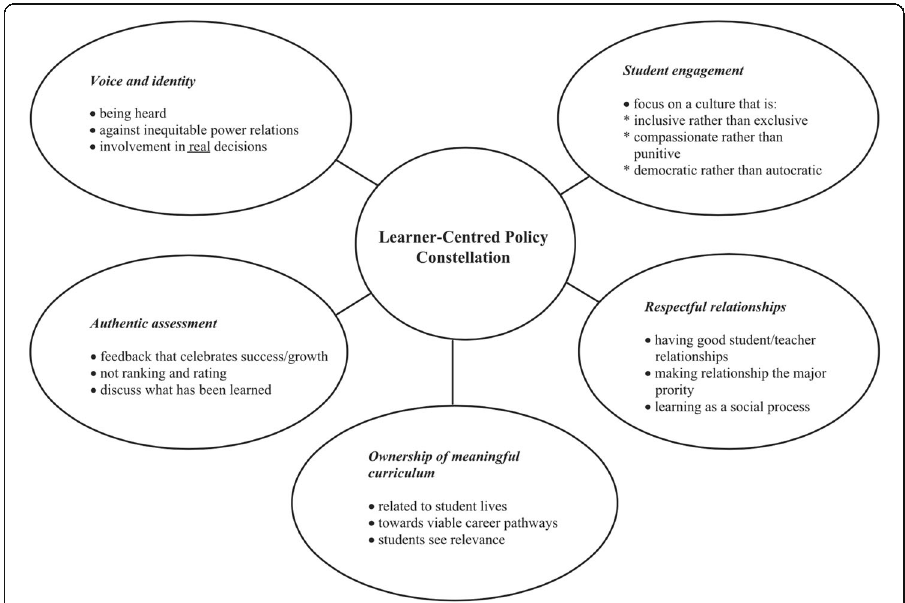
Fig. 1. Learner-centred policy